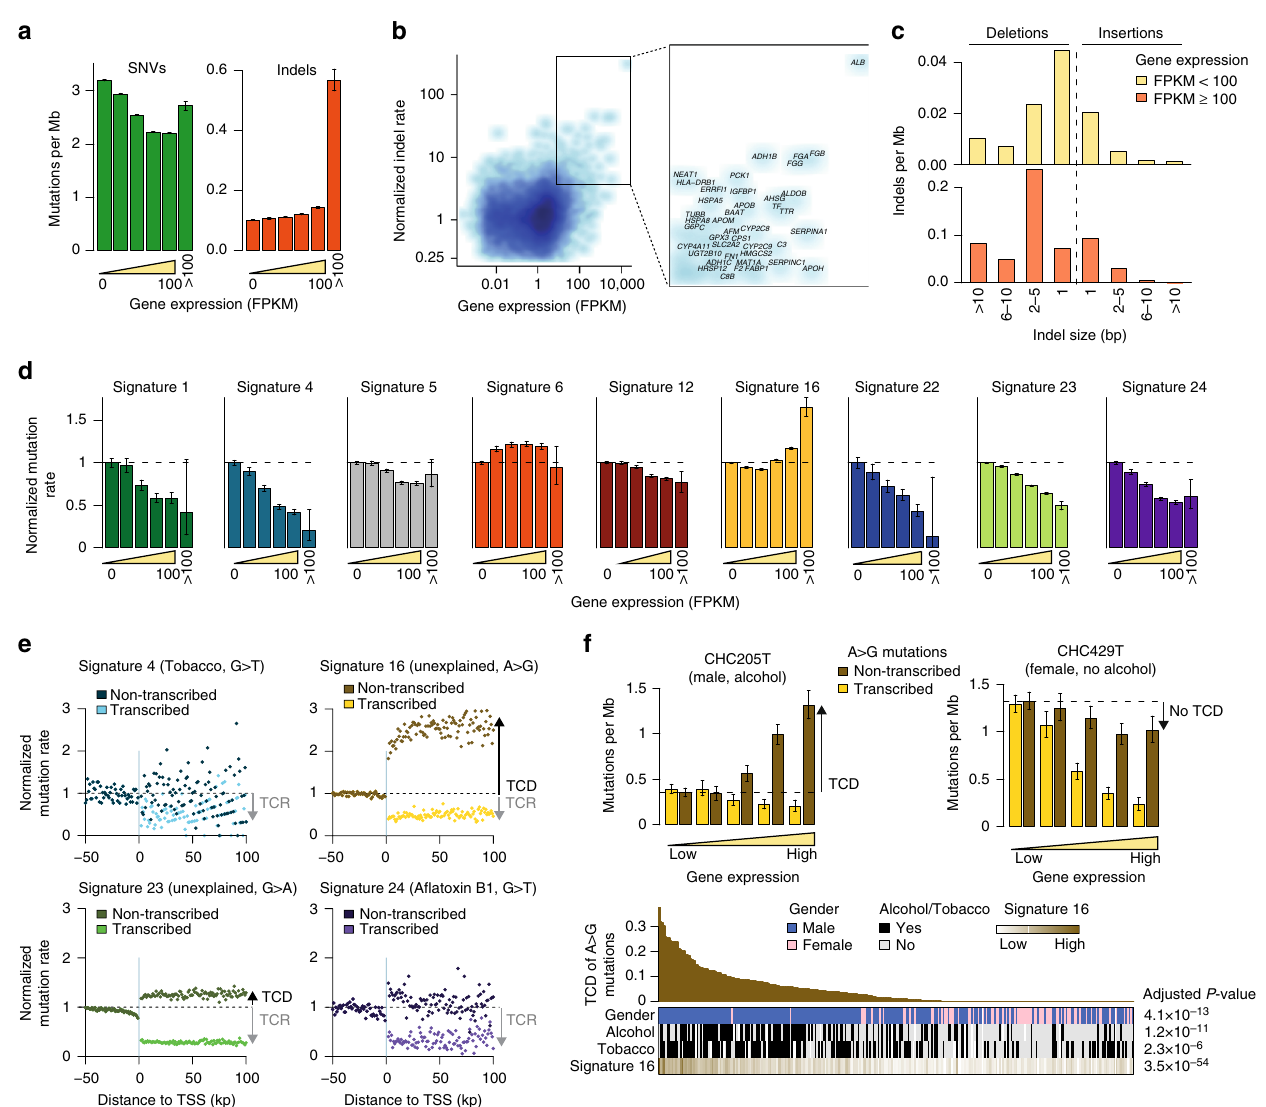
Fig. 2 Gene expression strongly modulates mutational processes in liver cancer. a Number of single nucleotide variants (SNVs, left) and small insertions and deletions (indels, right) per megabase in genes as a function of expression level. Genes with expression between 0 and 100 fragments per kilobase of exons per million reads (FPKM) were divided in 5 gene expression quintiles. A separate group was created for very highly expressed genes (FPKM ≥ 100). Error bars indicate the 95% con fi dence intervals of the estimated mutation rates. b Per-gene correlation of indel rate with gene expression. The normalized indel rate represents the number of indels per megabase in each gene divided by the indel rate in unexpressed genes (FPKM = 0). Very highly expressed genes with a high indel rate are represented in a zoomed box on the right. c Distribution of indel types and sizes in very highly expressed (FPKM ≥ 100) vs. all other genes. d Correlation between gene expression and SNV rates broken down by mutational signature. Mutation rates were normalized against the mutation rate in unexpressed genes. e Evolution of mutation rates when crossing transcription start sites (TSS) for the 4 mutational signatures with the strongest transcriptional strand bias. Each dot represents the average mutation rate in a 1-kb window between 50 kb upstream and 100 kb downstream transcription start sites, normalized against the mutation rate in intergenic regions. In transcribed regions, the mutation rate was estimated separately on the transcibed (light) and non-transcribed (dark) DNA strands. Black and gray arrows represent the shifts in mutation rate attributed to transcription- coupled repair (TCR) and transcription-coupled damage (TCD). f Transcription-coupled damage was quanti fi ed in each tumor as the increase of A > G mutations between low and high expression genes (top). Bottom: Correlation of TCD with clinical and molecular